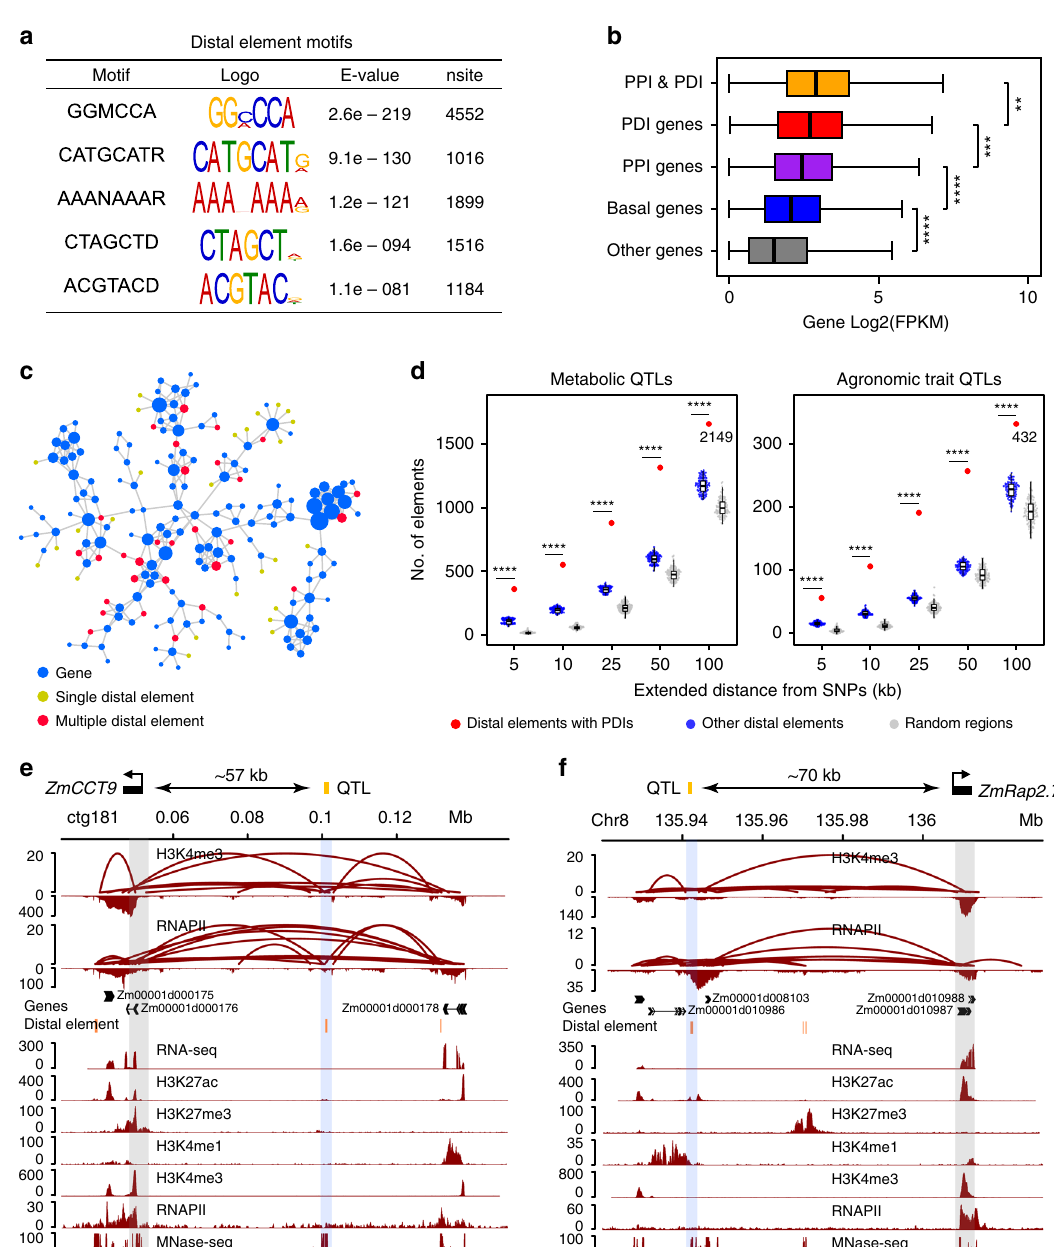
Fig. 5 Chromatin loops connect QTLs to the genes causing phenotypic changes. a The fi ve most common motifs from distal elements. b Expression analysis of genes (with FPKM > 1) involved in PDI and PPI ( n = 4571), PDI genes ( n = 621), PPI genes ( n = 10,705), basal genes ( n = 4959), and other genes ( n = 877). Basal genes: genes containing H3K4me3 or RNAPII peaks but not involved in chromatin interaction; Other genes: genes neither marked with H3K4me3 or RNAPII peaks nor engaged in chromatin loops. **** P < 0.0001, *** P < 0.01, ** P < 0.05 from Wilcoxon test. Boxplots show the median, and third and fi rst quartiles. The whiskers are de fi ned as 0.25 – 1.5 IQR/0.75 + 1.5 IQR, IQR is interquartile range. c Clusters of single distal elements and multiple distal elements (single distal elements represent those distal elements interacting with one gene, multiple distal elements represent those distal elements interacting with multiple genes). d Number of interaction distal elements detected at the indicated distance from single nucleotide polymorphisms (Other distal elements: distal elements without interactions. Random regions: random regions from genome). **** P < 0.0001 from T -test. Values represent numbers of distal elements and random regions. e Chromatin interactions and ChIP-Seq pro fi les at ZmCCT9 (Zm00001d000176). f Chromatin interactions and ChIP-Seq pro fi les at vgt1 (Zm00001d010987). Source Data underlying ( b , d ) are provided in a Source Data fi le Analysis of sequencing data . Several data sets used in this study are already (mapping quality <30) were removed, while PCR duplicate reads were excluded by SAMtools 34 . To assess repeatability, we calculated coverage of the genome per 10 published, including methylation 29 , and chromatin accessibility data 24 . RNA-Seq data from 16 days seedlings consistent with the ChIA-PET experiment. We kb and normalized the coverage by reads per kilobase per million mapped reads removed the sequencing adapter and reads with low quality score from paired-end (RPKM) using deepTools2 35 . Regarding pro fi les and heat maps surrounding reads of ChIP sequencing, MNase sequencing, RNA sequencing, and bisul fi te transcription start sites, the coverage was generated with the genome binned at 50 sequencing by Trimmomatic 30 . These clean reads were further aligned to the maize bp. Based on the histone differences in the distribution of TSS regions of all genes on the maize genome, we divided them into 15 categories based on k-means cluster genome (B73 AGPv4) using BWA 31 , TopHat 32 , and BatMeth2 33 with default analysis. Read-enriched peaks were identi fi ed by MACS 36 . Among them, parameters, respectively. Unmapped reads and non-uniquely mapped reads NATURE COMMUNICATIONS| (2019) 10:2632